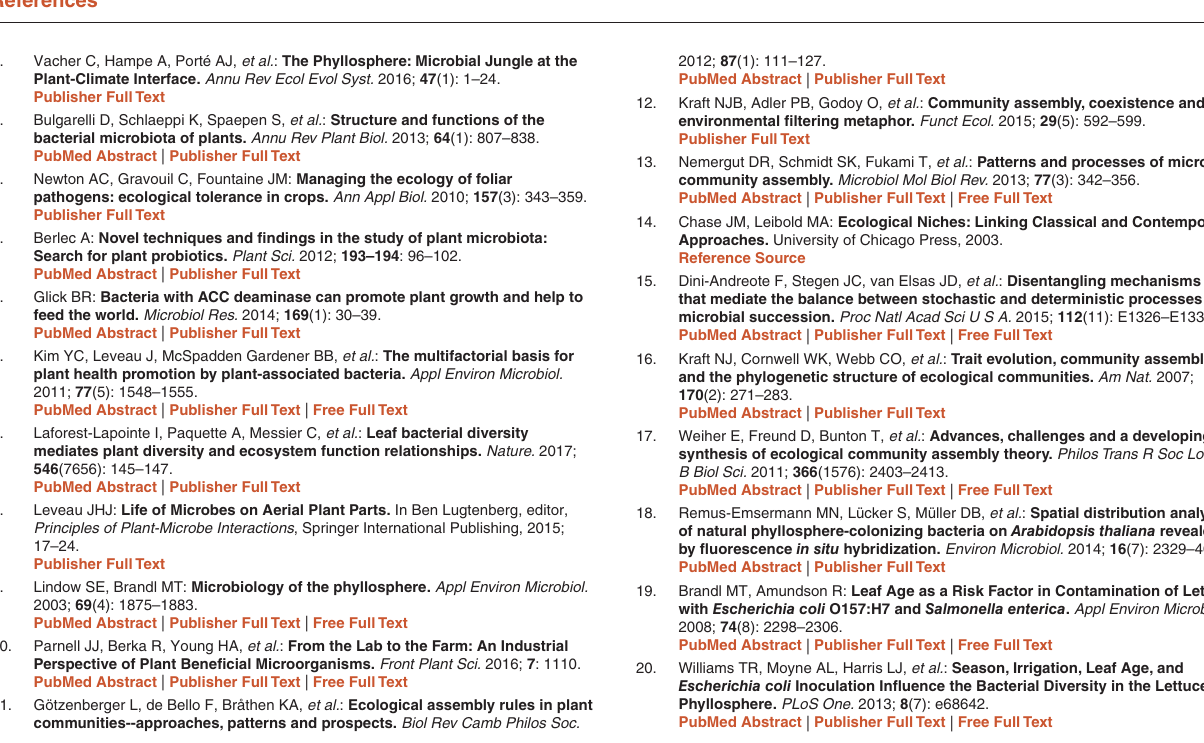
Supplementary material Supplementary Figure S1: a-n Arisa Plots of Signifcant Co-occurring OTU Pairs. Click here to access the data. Supplementary Figure S2: a-n Plots of SEM datatype co-occurrence at each growth stage. Click here to access the data. Supplementary Figure S3: SEM Core SCU. Click here to access the data. Supplementary Results. Click here to access the data. Supplementary Table 1. Click here to access the data. Supplementary Table 2. Click here to access the data. Supplementary Table 3. Click here to access the data. Supplementary Table 4. Click here to access the